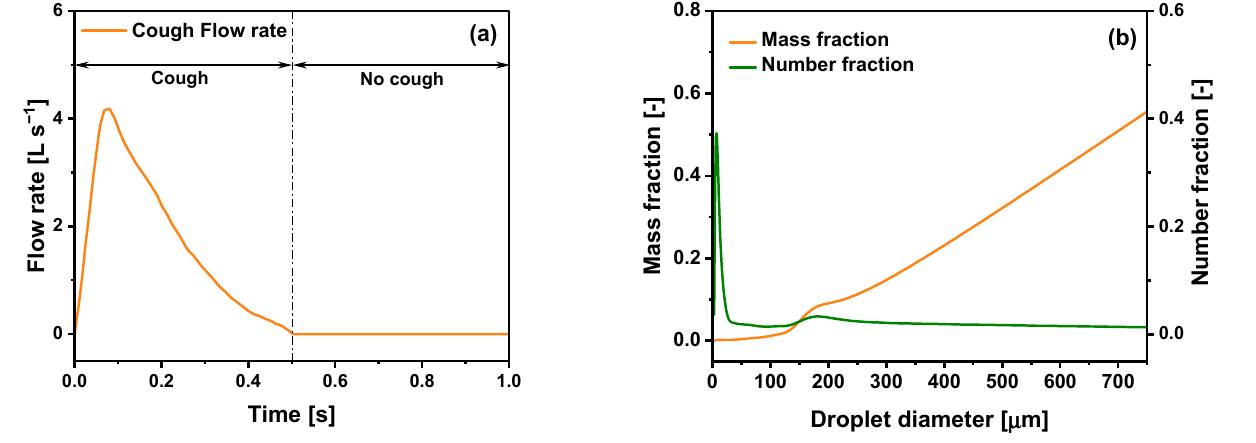
Figure 3. Boundary conditions of ( a ) cough flow rate; and ( b ) mass and number fractions of droplets.